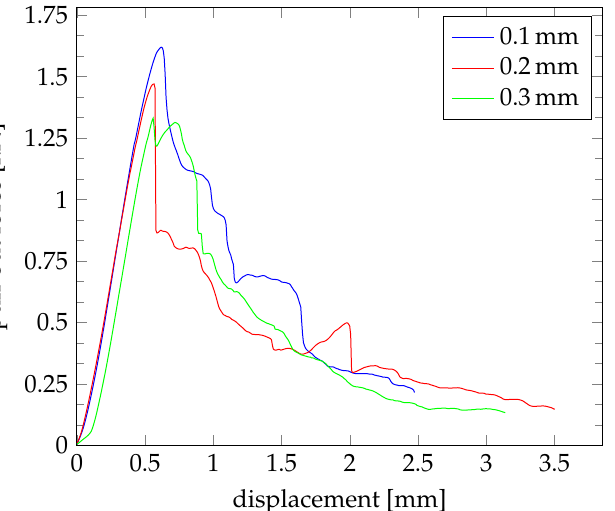
Figure 12. Characteristic force-displacement graphs of the pull-out tests for variations of the layer